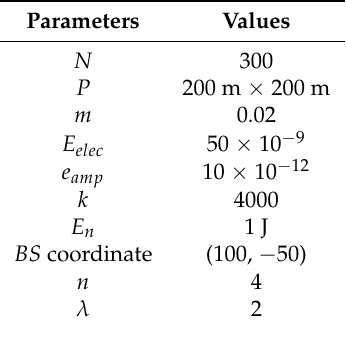
Table 2. Simulation parameters.